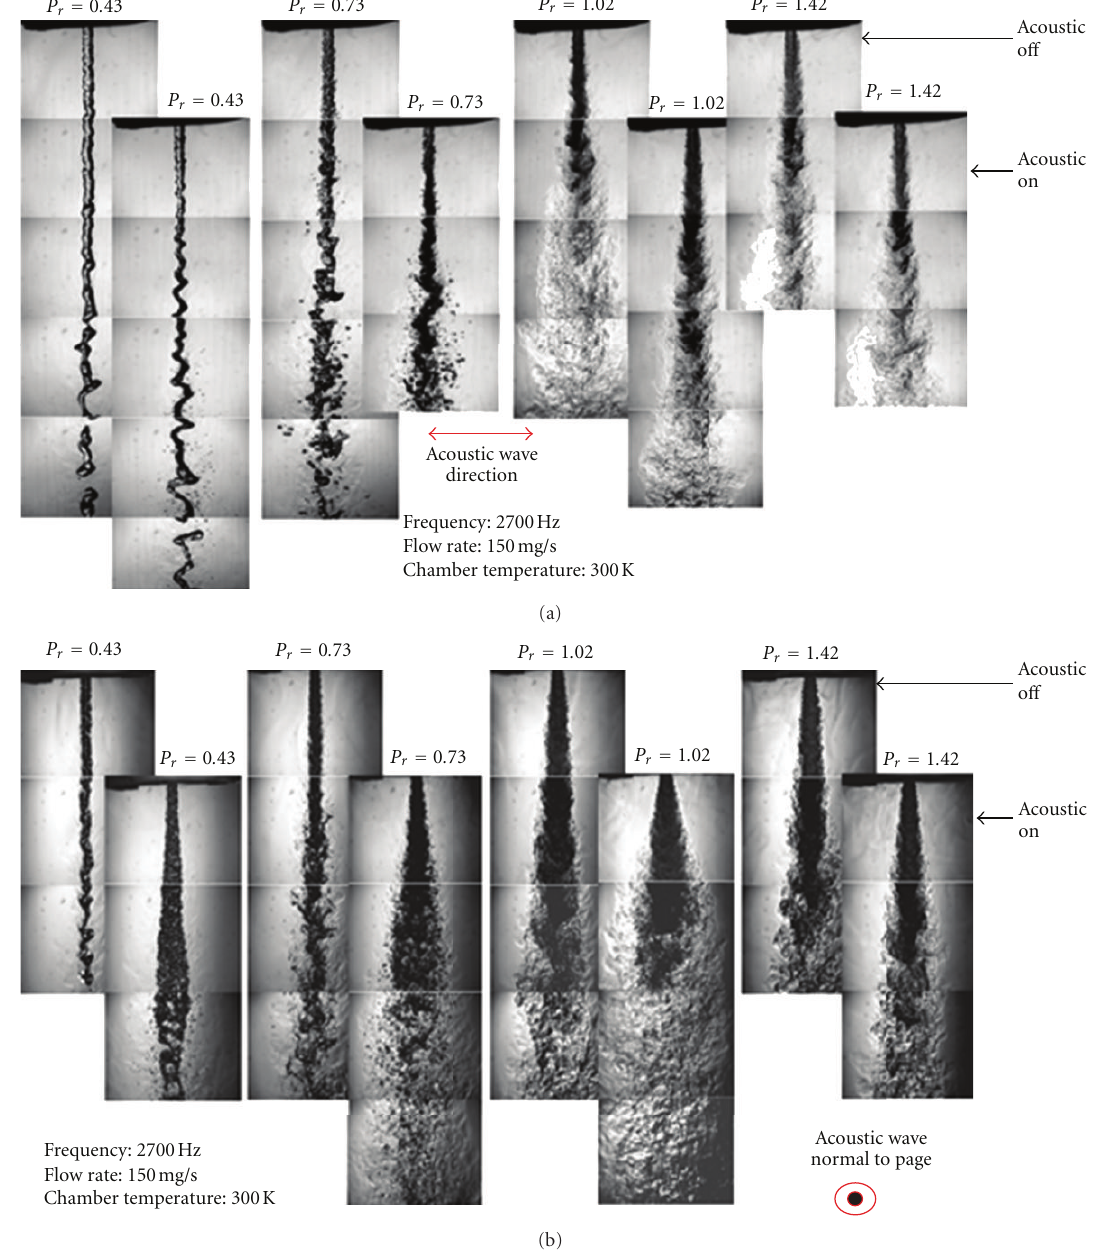
Figure 14: Interaction of acoustic waves with a single round liquid nitrogen jet injected into gaseous nitrogen at a range of chamber pressures from sub- to supercritical conditions. (a) Top images show front view; only one acoustic driver located at the left of the jet. The set of images shifted downward are when the acoustic field is turned on as indicated. (b) Bottom images show side views of the same jet (the same acoustic driver is located behind this page). P r is the reduced chamber pressure (i.e., chamber pressure divided by the critical temperature of the injected nitrogen). Chehroudi and Talley